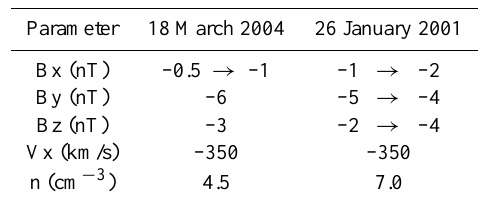
Table 2. Average values of the IMF and solar wind plasma parame- ters for 18 March and 26 January events. The arrow means that the parameter changes with